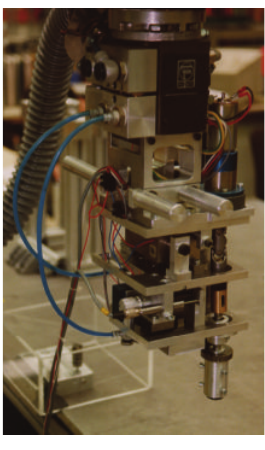
Figure 2: Vibration module.